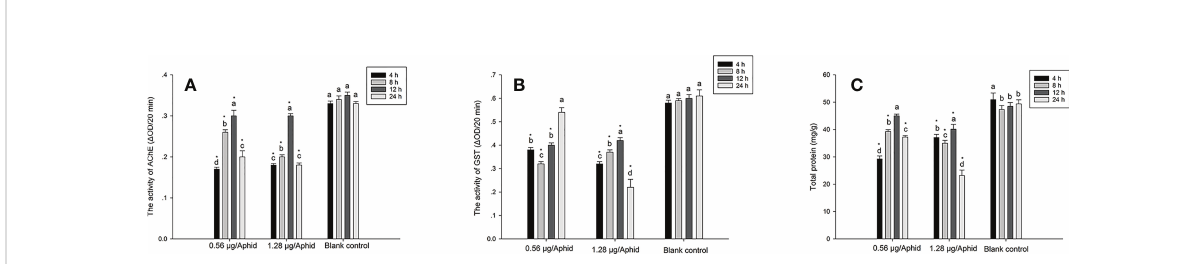
FIGURE 1 Effect of PSO (pomelo seed oil) at the dose of 0.56 m g/aphid (LC 30 ) or 1.28 m g/aphid (LC 50 ) on some biochemical properties of Aphis craccivora , (A) : In vivo AChE activity; (B) : In vivo GST activity; (C) : Total protein content. The different lowercase letters within the same treatment group indicate signi fi cant difference (p < 0.05). The * indicates signi fi cant difference (p < 0.05) compared to the corresponding blank control group at the same time